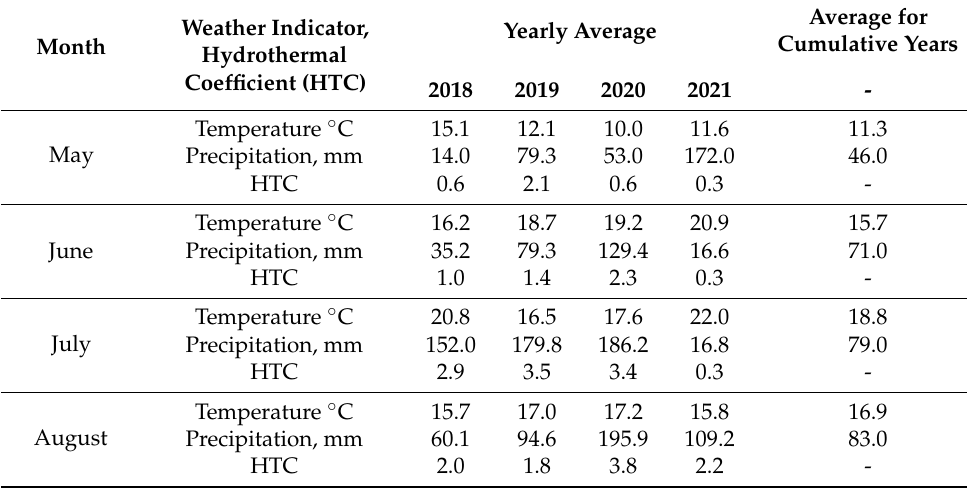
Table 1. The weather conditions during summer period in the research